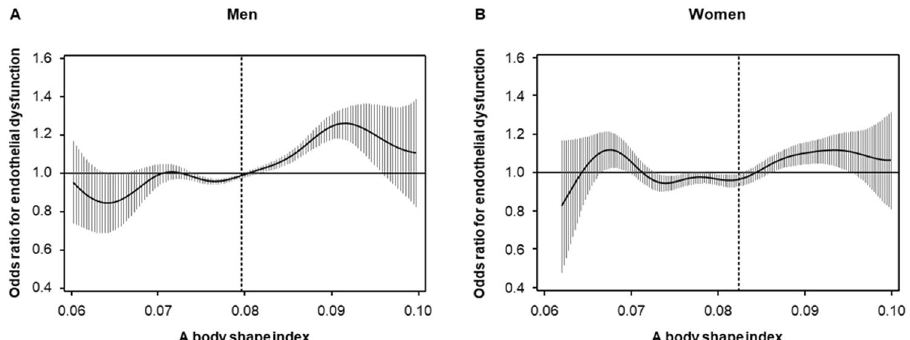
Figure 3. Adjusted cubic spline of the relationship between a body shape index (ABSI) and odds ratio for endothelial dysfunction in men ( A ) and in women ( B ). Endothelial dysfunction was defined as FMD of less than 3.6% in men and FMD of less than 3.1% in women. The adjusted model includes age, body mass index, and smokers. Vertical lines show 95% confidence intervals. Dashed vertical lines represent the cutoff values of ABSI for endothelial dysfunction that were derived from ROC curve analysis (0.0796 for men and 0.0823 for women).